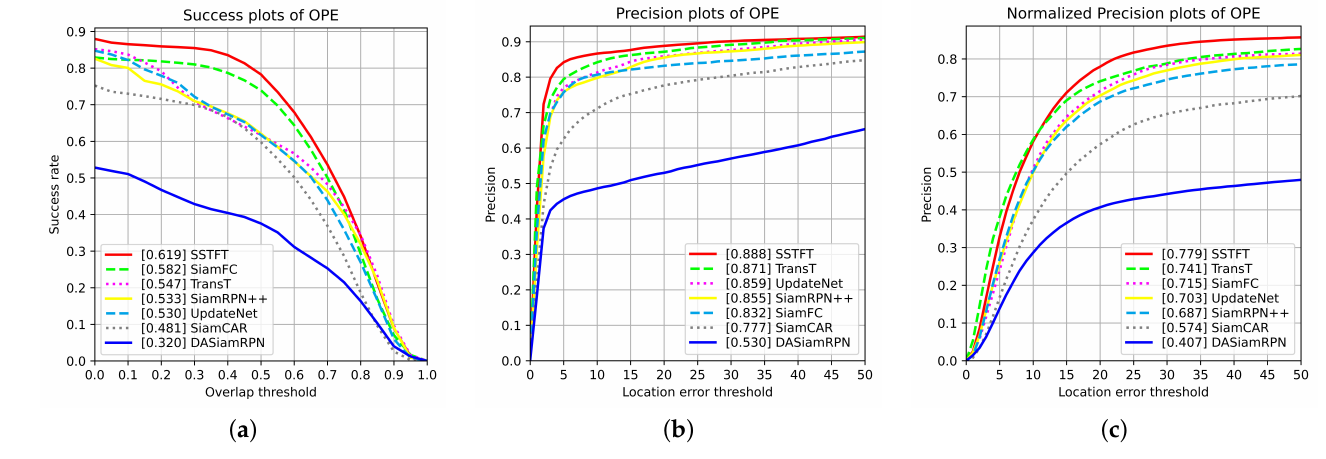
Figure 5. Comparisons with deep learning trackers on IMEC25. The floating point of operations (FLOPs) and parameters are reported in Table 4, from which it can be obviously found that our method has the lowest computational complexity. Table 4. Model complexity